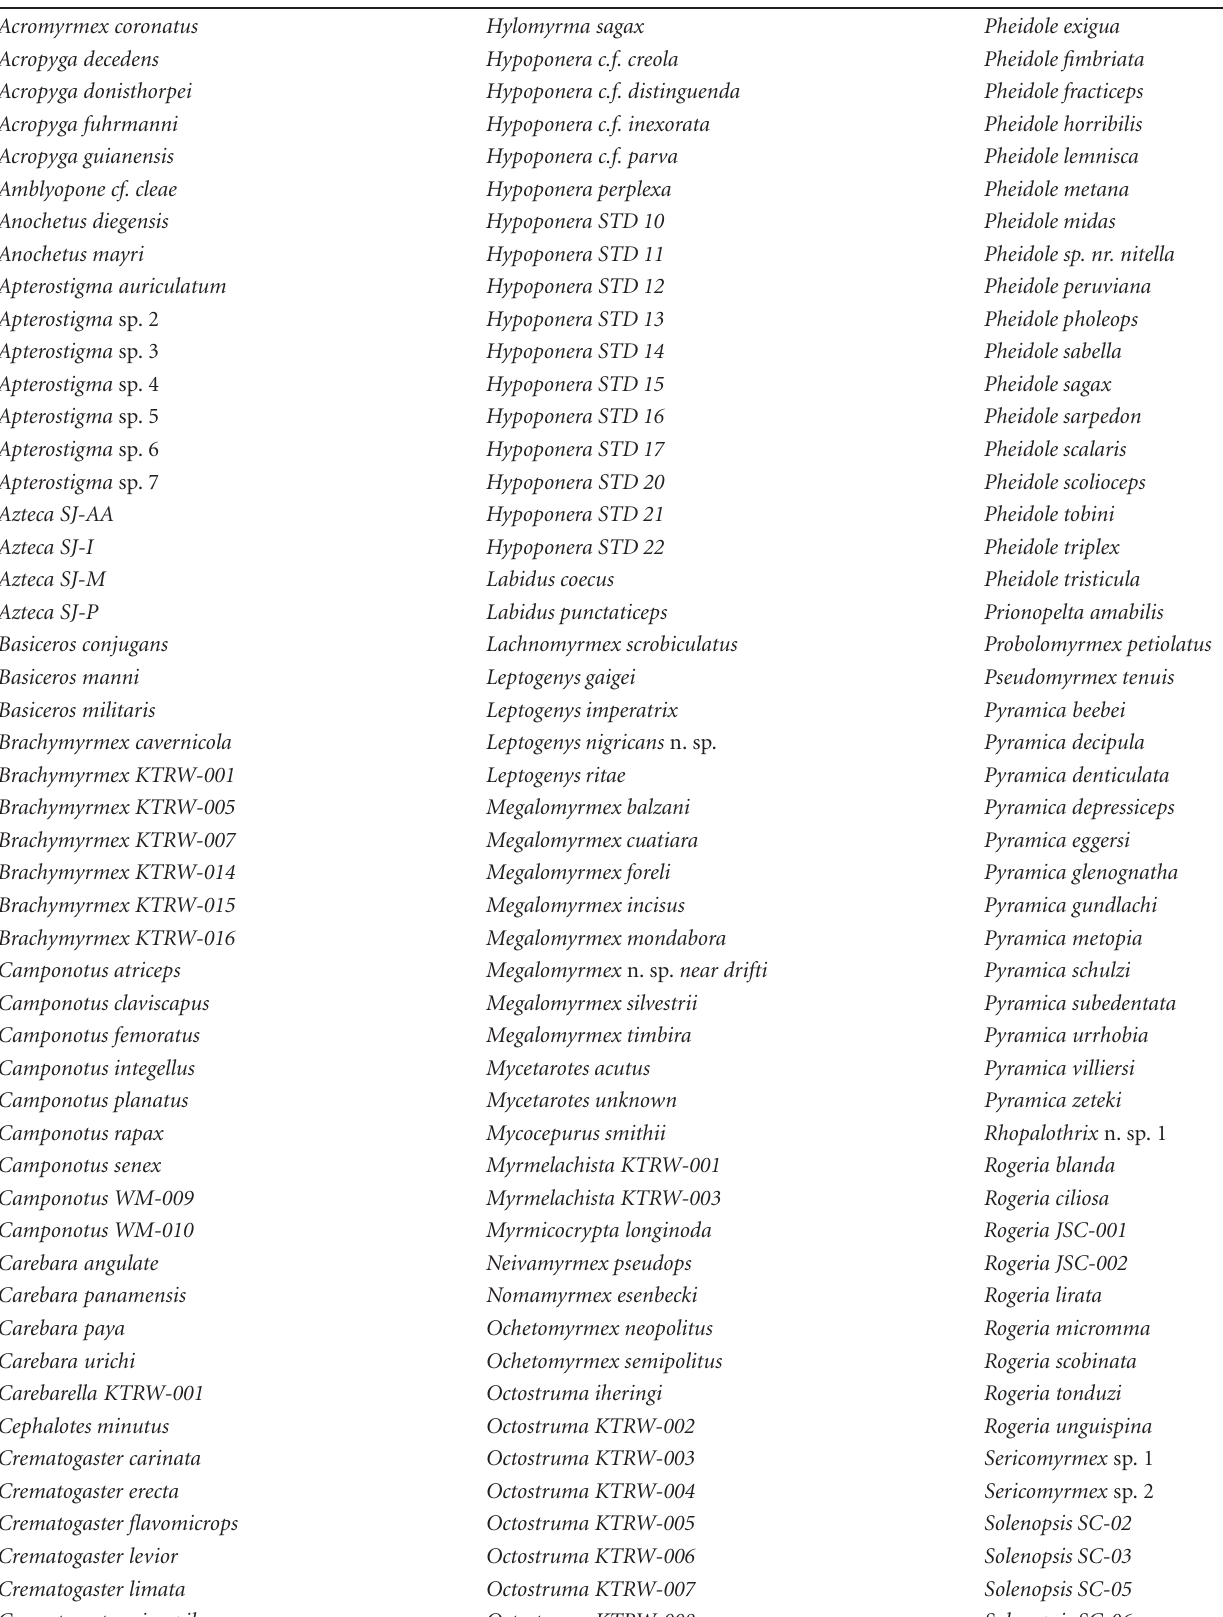
Table 2: List of ant species collected from ground samples at